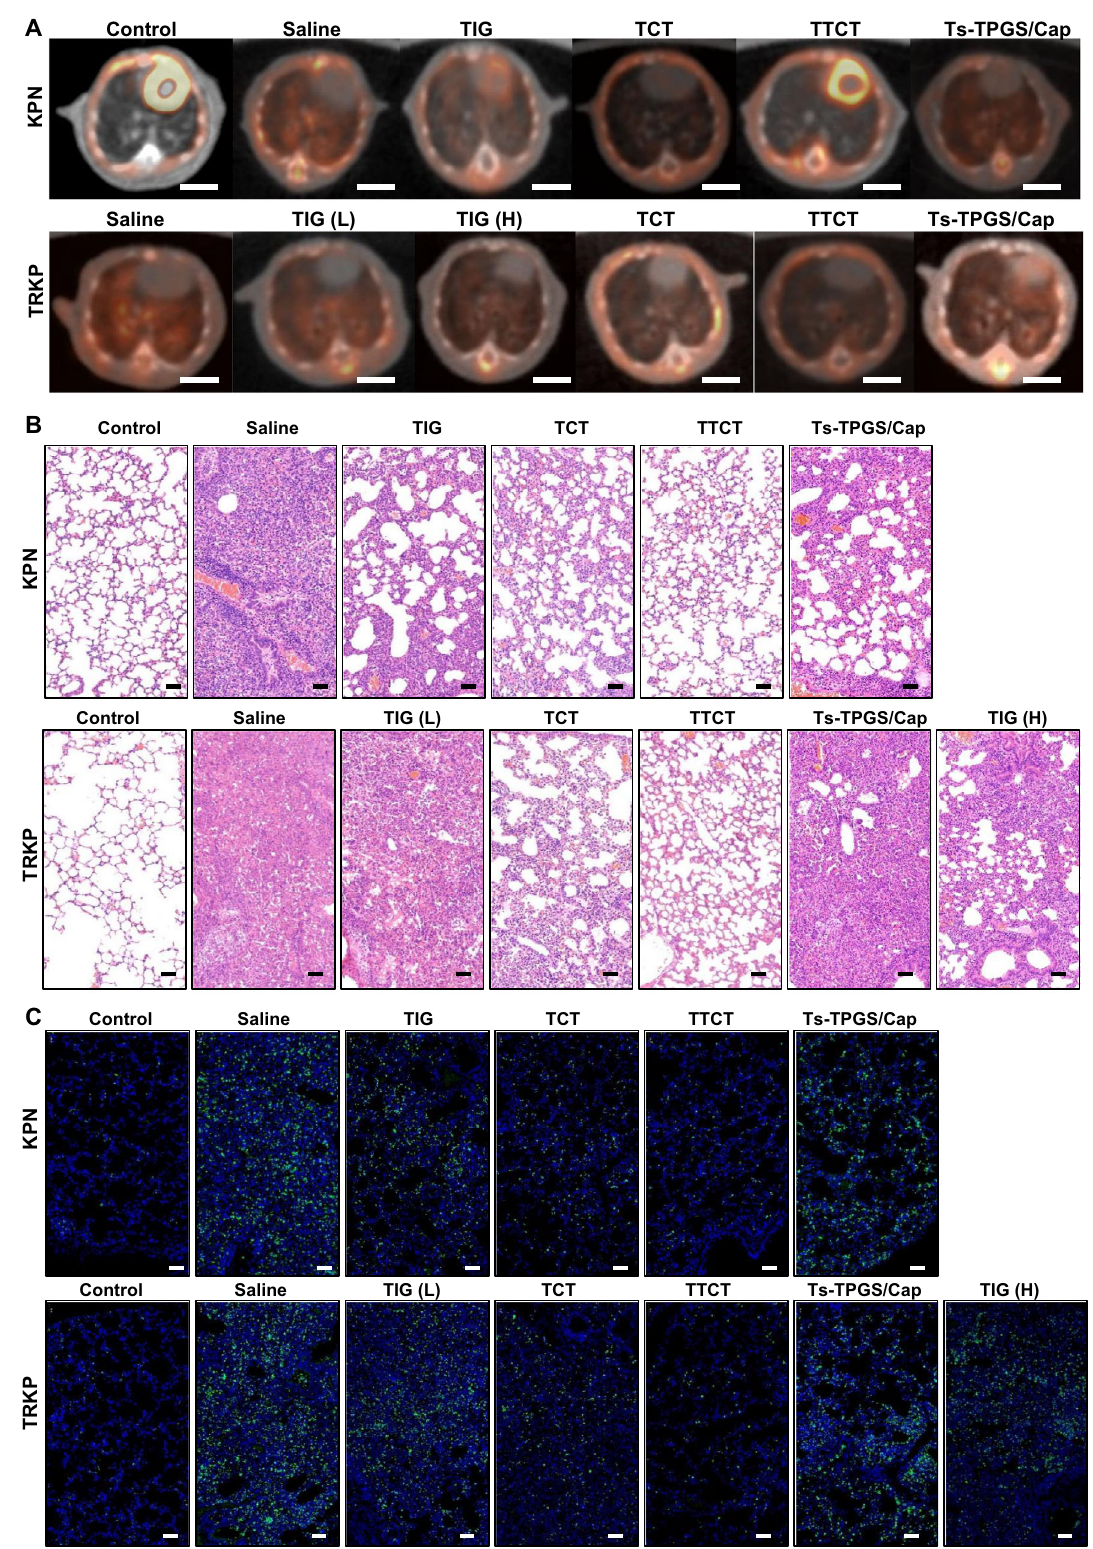
Fig. 8 Histopathology observation of lung tissue. A Representative images of the lungs observed by PET-CT after administration to various groups (Scale bar = 5 mm). B Representative images of lung tissue from different groups after H&E staining (scale bar = 50 µ m). C Fluorescent images of the lung tissue collected from mice with pneumonia and stained with anti-MPO antibody, in which the green channel indicates neutrophil in fi ltration and the blue channel represents the nucleus. Scale bar = 50 µ m. TIG free tigecycline, TIG(L) low dose of tigecycline (15 mg/kg), TIG (H) high dose of tigecycline (45